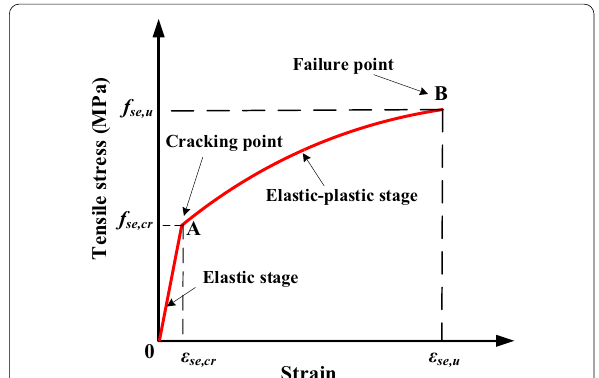
Fig. 10 A typical tensile stress–strain model curve for HSSSWR-reinforced